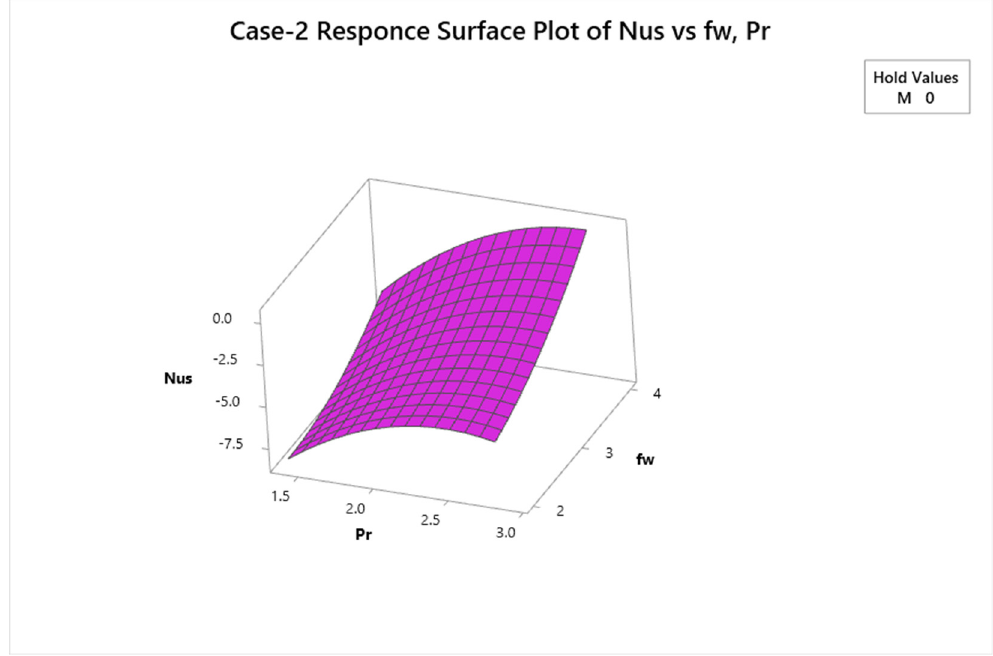
Figure 15. RSM plot for Nusselt number Vs fw , M of Case-2.